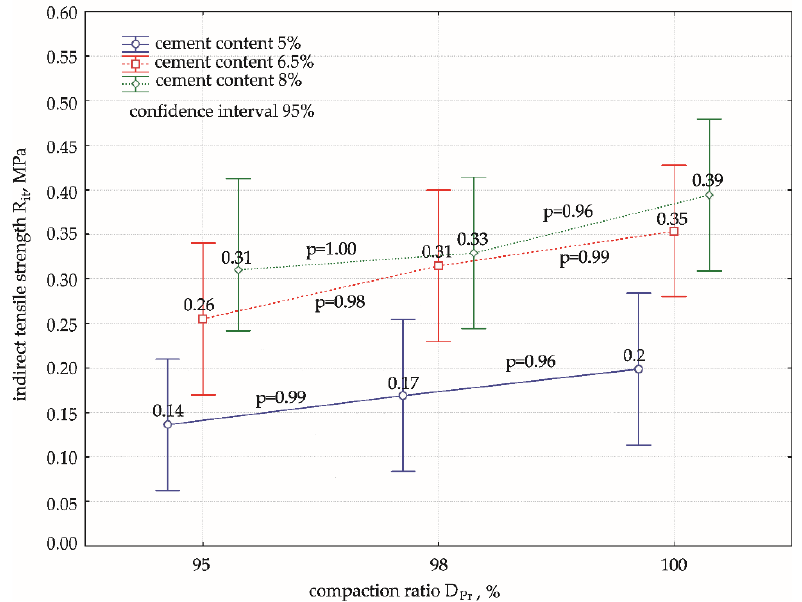
Figure 7. Diagram of variance of 𝑅 𝑖𝑡 values and significance of differences between pairs of means. Cement content: — 5%, — 6.5%, — 8%.